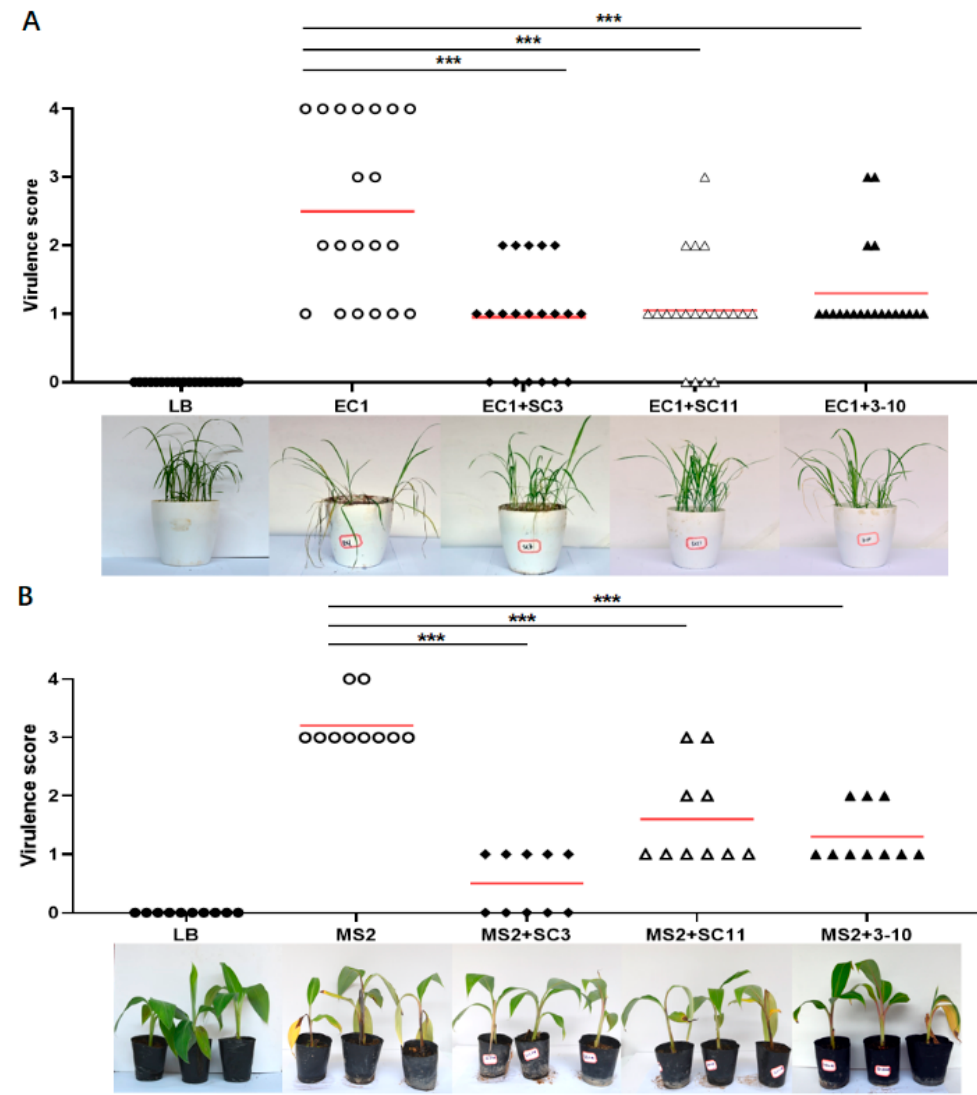
Figure 4. Biocontrol efficacy of antagonistic bacterial strains against rice foot rot and soft rot diseases on monocotyledonous rice ( A ) and banana seedlings ( B ). EC1, MS2 and antagonistic bacteria were grown in LB medium till OD 600 ≈ 1.8. Ten milliliters of LB, EC1+LB and EC1+antagonistic bacterium was respectively irrigated into the pots with 20 rice seedlings after needle punctures on stem bases. Two hundred microliter of LB, MS2+LB and MS2+antagonistic bacteria was respectively injected into the pseudostems of banana seedlings. Plants were incubated at 28°C with 12 h alternating light-dark cycles for 7 days, and disease was assessed by using virulence scoring method described previously. Data were subjected to unpaired two-tailed t-test analysis by Graphpad Prism 8.4.1 (*** p < 0.001). The marks in the plot area represent the virulence scores of the inoculated plant seedlings, and the red lines represent the average virulence scores.